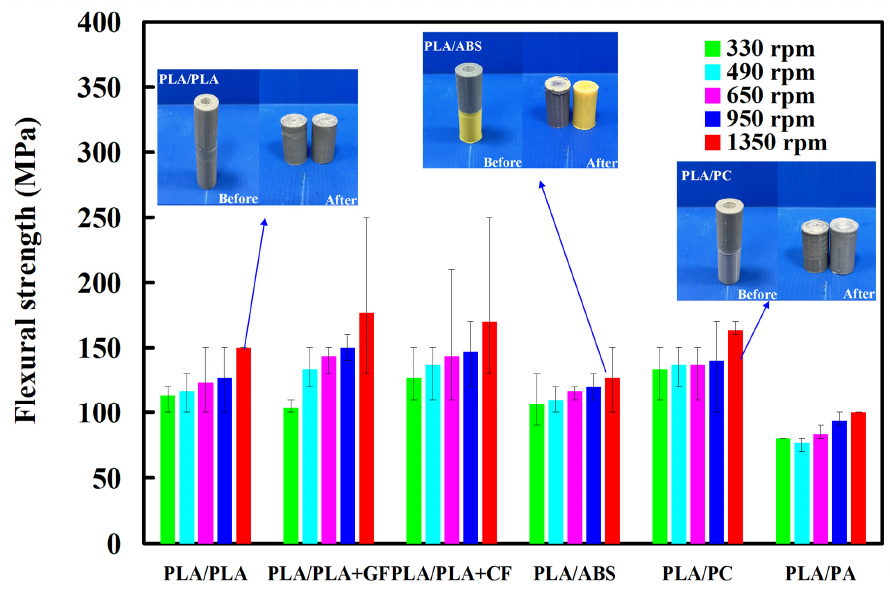
Figure 17. Flexure strength of dissimilar polymer rods welded at five different rotational speeds.